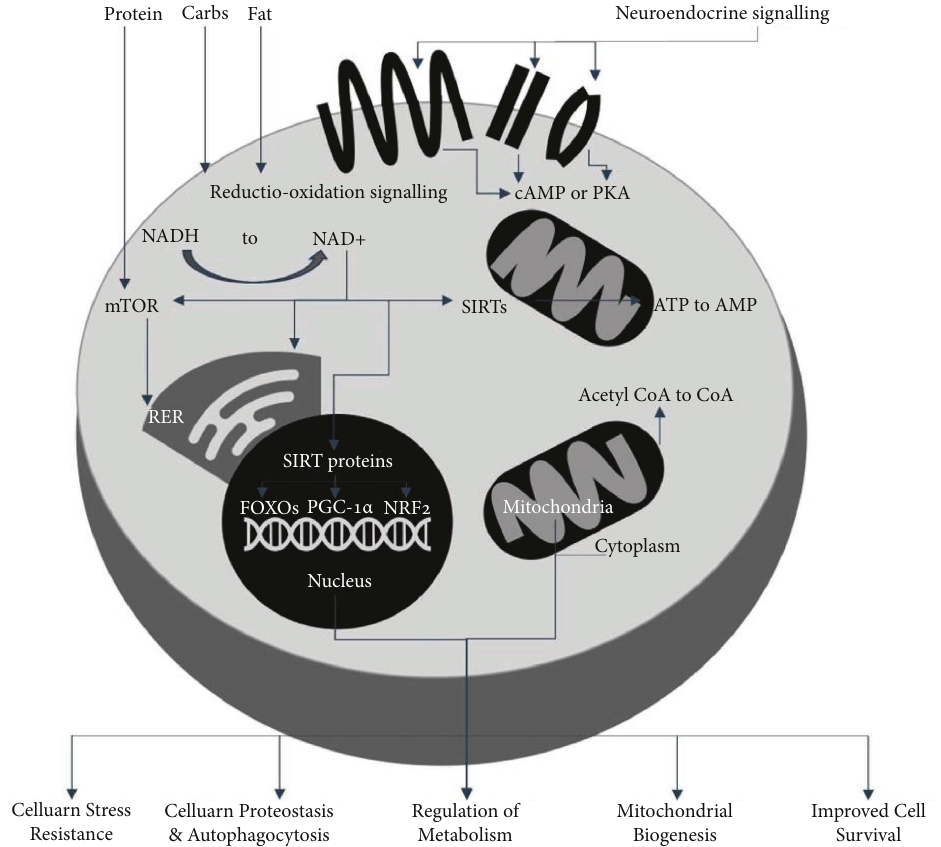
Figure 4: Cellular metabolic pathways and responses to intermittent fasting showing downstream cascade effects of fasting and resulting beneficial outcomes {NAD+ (nicotinamide adenine dinucleotide); transcription factors FOXOs (forkhead box Os), PGC-1 α (proliferator- activated receptor c coactivator 1 α ), and NRF2 (nuclear factor erythroid 2-related factor 2); kinases AMPK (AMP kinase) and cAMP cyclic AMP; and deacetylases sirtuins (SIRTs); mammalian target of rapamycin (mTOR); insulin-like growth factor 1